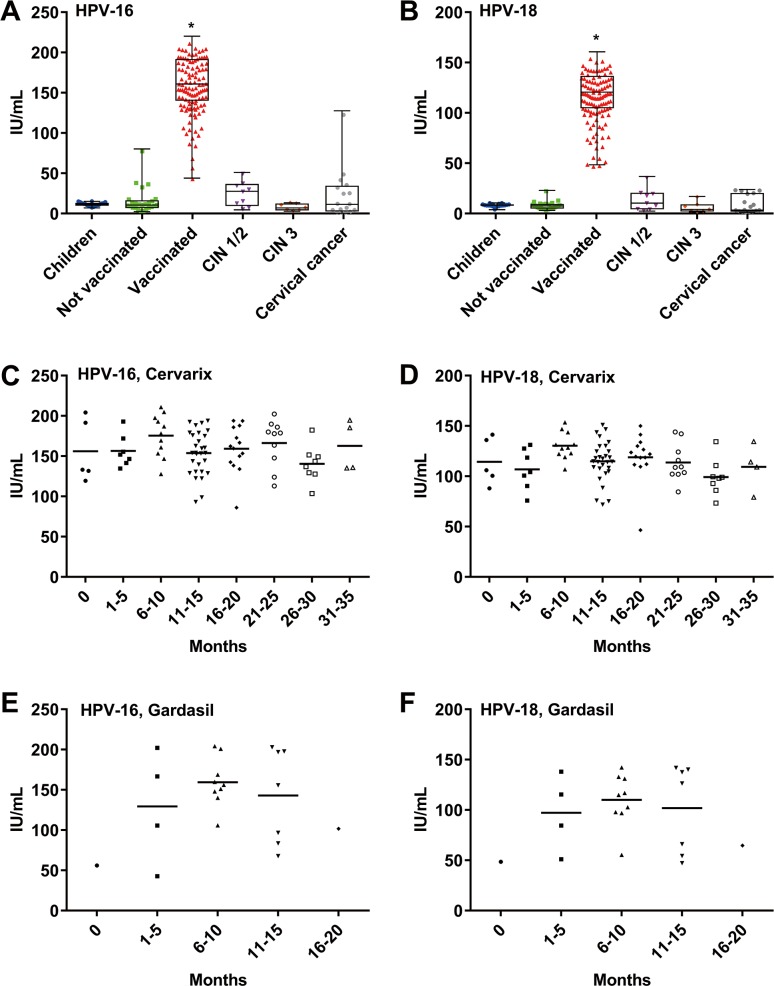
Comparison of the serum levels of HPV-16/-18 Abs in healthy and clinically diagnosed groups.The levels of HPV-16/-18 Abs were measured using serum samples from children (Children), unvaccinated healthy women (Not-vaccinated), and vaccinated healthy women (Vaccinated), as well as from patients diagnosed as having cervical intraepithelial neoplasia grade 1 or 2 (CIN 1/2), CIN 3, or cervical cancer. A and B. Comparison of anti-HPV-16/-18 Ab concentrations in the sera of each category. Asterisk (*) represents p < 0.001, one-way ANOVA. C–F. Change in serum HPV-16/-18 Ab concentration at the indicated times post vaccination with Cervarix (C and D) and Gardasil (E and F).